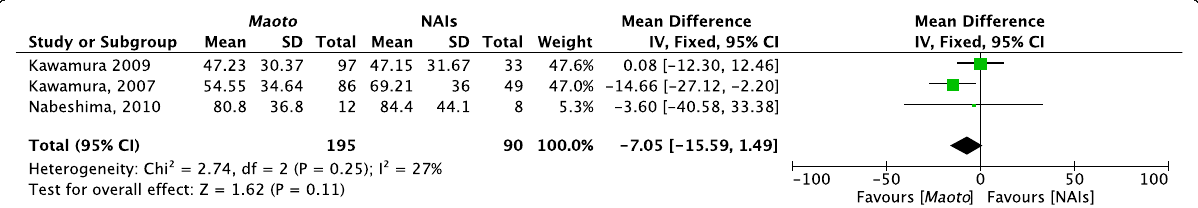
Fig. 4 Forest plot of overall symptom duration after drug administration: maoto vs. neuraminidase inhibitors (NAIs). The duration of symptoms does not differ significantly between maoto and NAIs. The heterogeneity is not significant ( P > 0.1, I 2 < 75%), and a fixed-effect model is used for this outcome. Kawamura [19, 23] defined the duration of symptoms as the time until complete disappearance of the symptoms, while Nabeshima et al. [25] defined it as the time during which the symptom score was over the cut-off point for